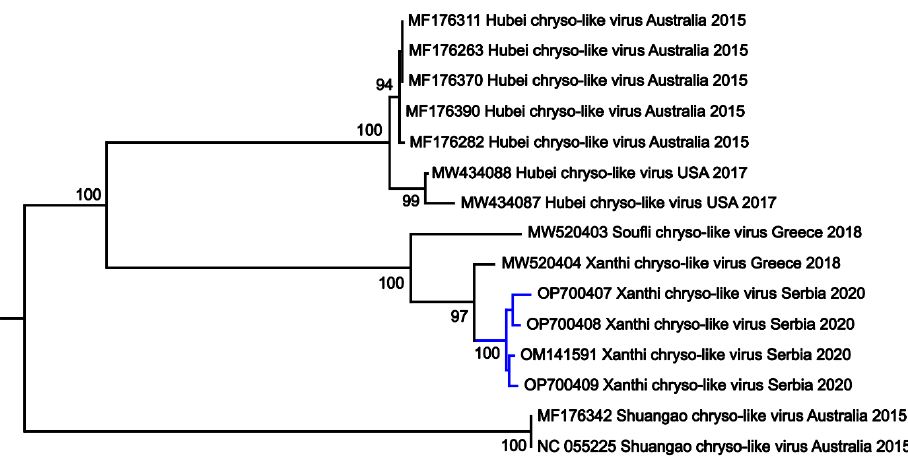
Figure 2. Maximum likelihood phylogenetic tree generated by MEGA X software, based on 735 nt of 15 chryso-like viruses. Bootstrap values > 65% are shown in the tree nodes. Sequences are indicated by GenBank accession number, name of the virus, country, and year of isolation. Newly detected sequences from Serbia are labeled in